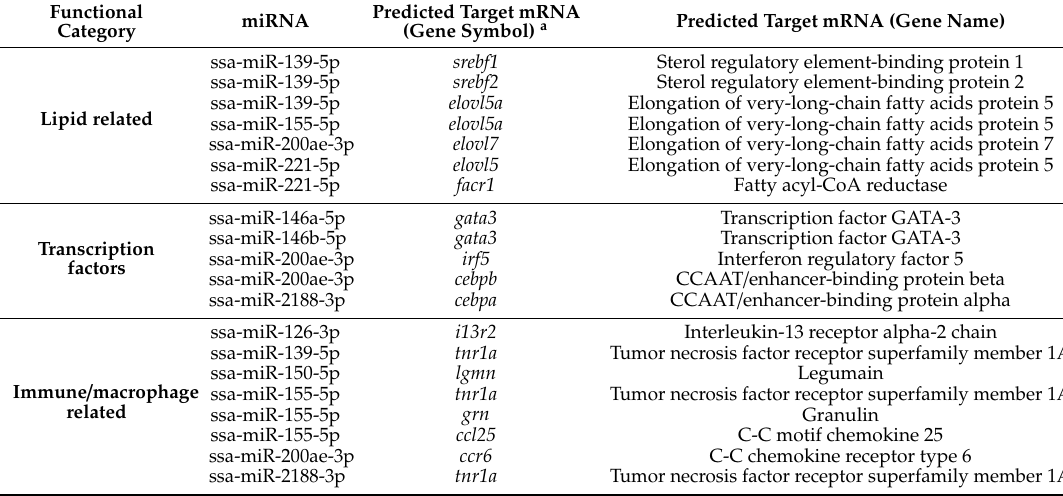
Table 3. Selected predicted miRNA